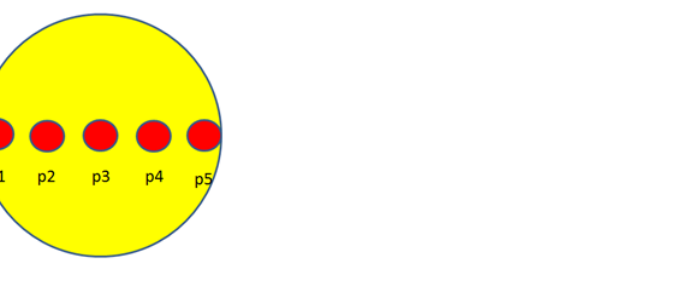
Figure 6. Points along the lens axis considered for the measure of the efficiency. Table 2. Mean values and the relative standard error of the efficiency obtained for each region. Region